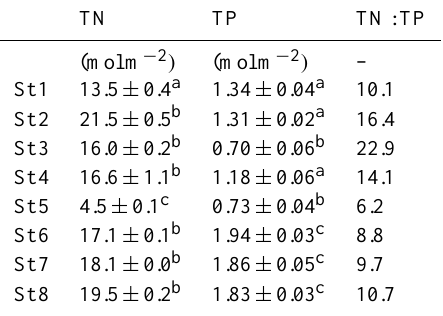
Table 2. Depth-integrated (0–16cm) area-specific TN and TP con- tent ± SE ( n = 3) at St 1–8. Superscript letters indicate the grouping of data obtained by ANOVA and subsequent post hoc analysis. Av- erage TN:TP ratios are also shown.